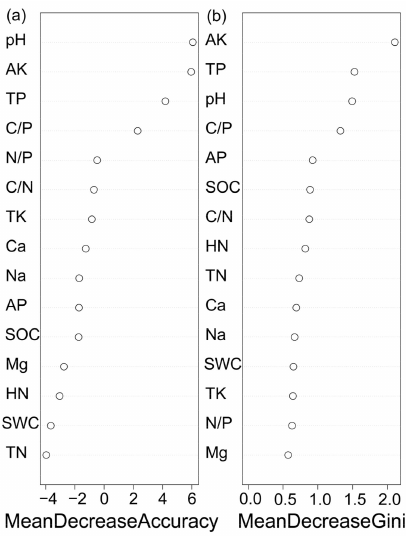
Figure 5. Ordination of variable importance derived from the Random forest (RF) models for the soil property variables. ( a ) Mean Decrease in Accuracy, ( b ) Mean Decrease in Gini.